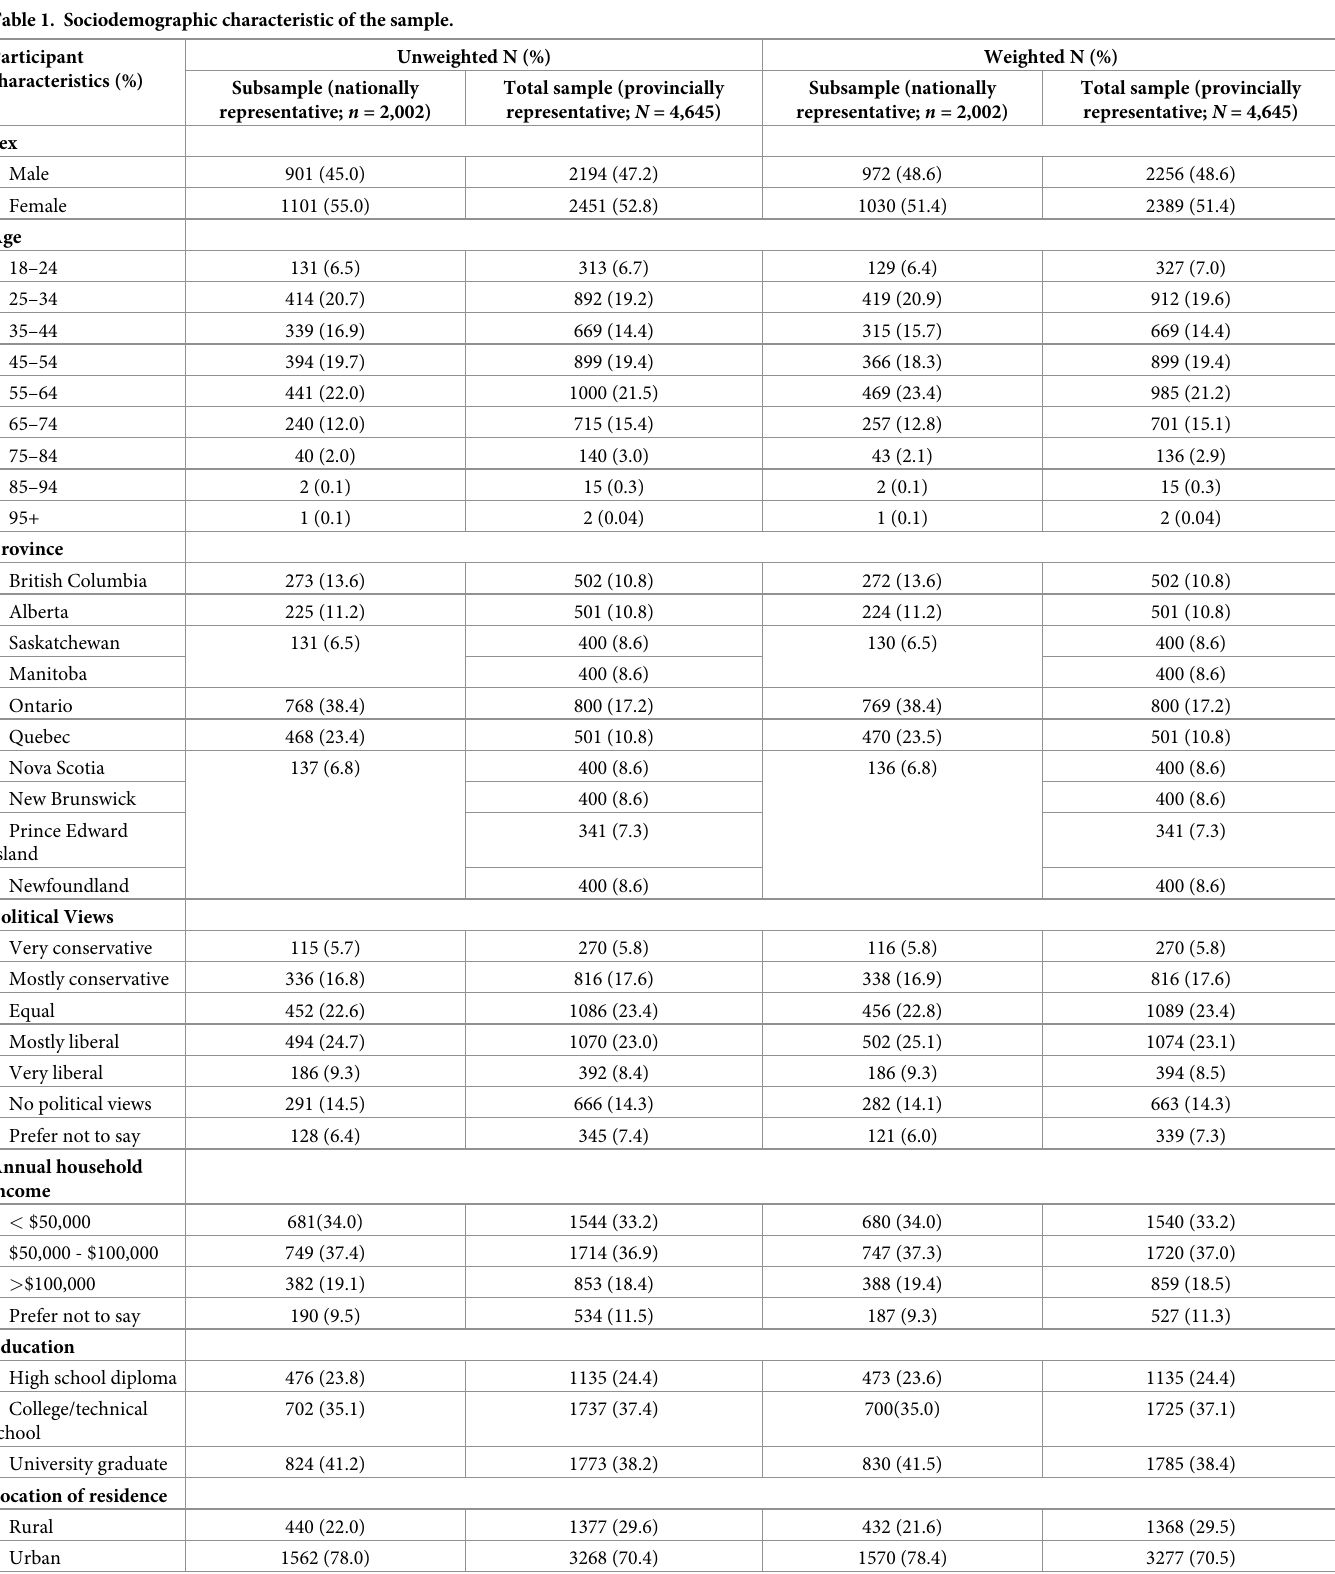
Table 1. Sociodemographic characteristic of the